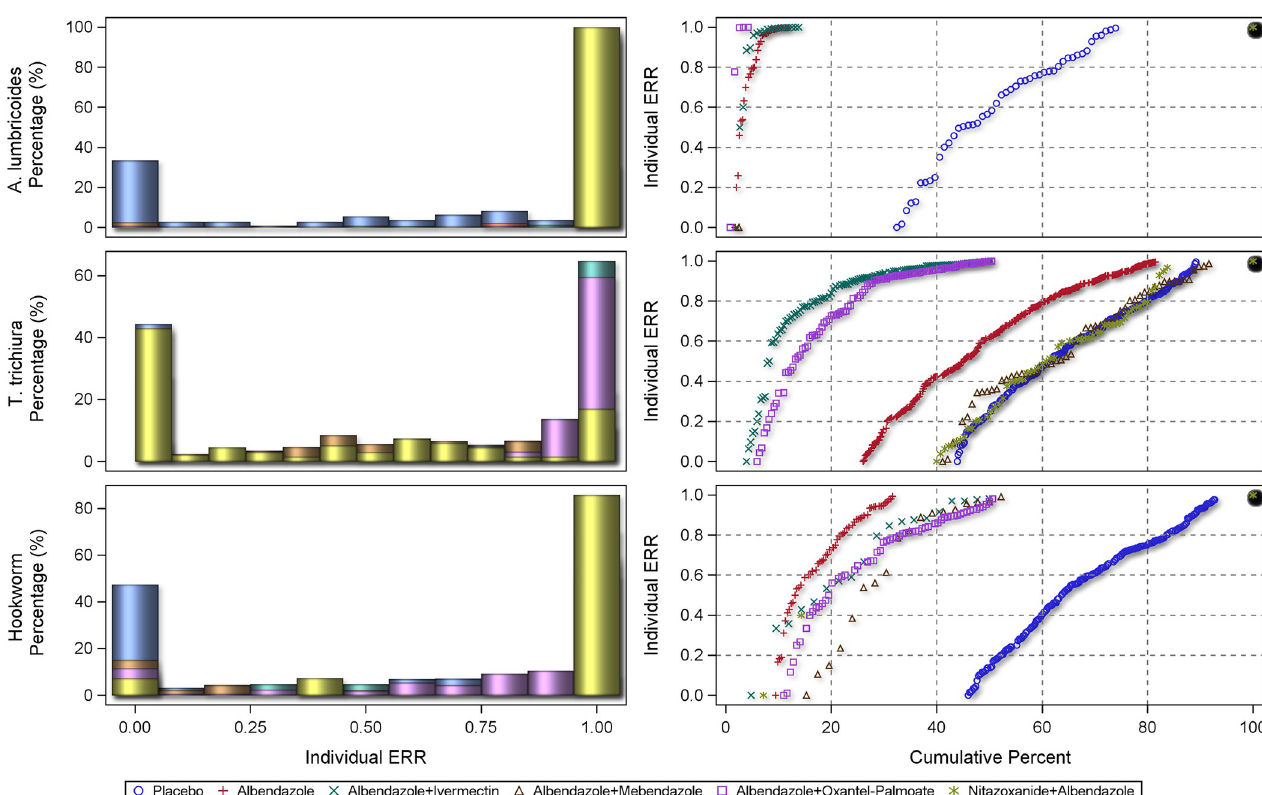
Fig 8. Distribution of individual responses in studies of 14–21 days follow-up for Ascaris lumbricoides , Trichuris trichiura and hookworm for albendazole and albendazole combinations. The right-hand plots show the proportions of people at a given ERR with colours related to placebo or a drug. The left-hand plots show cumulative distribution of ERR in people treated with a drug from 0 to